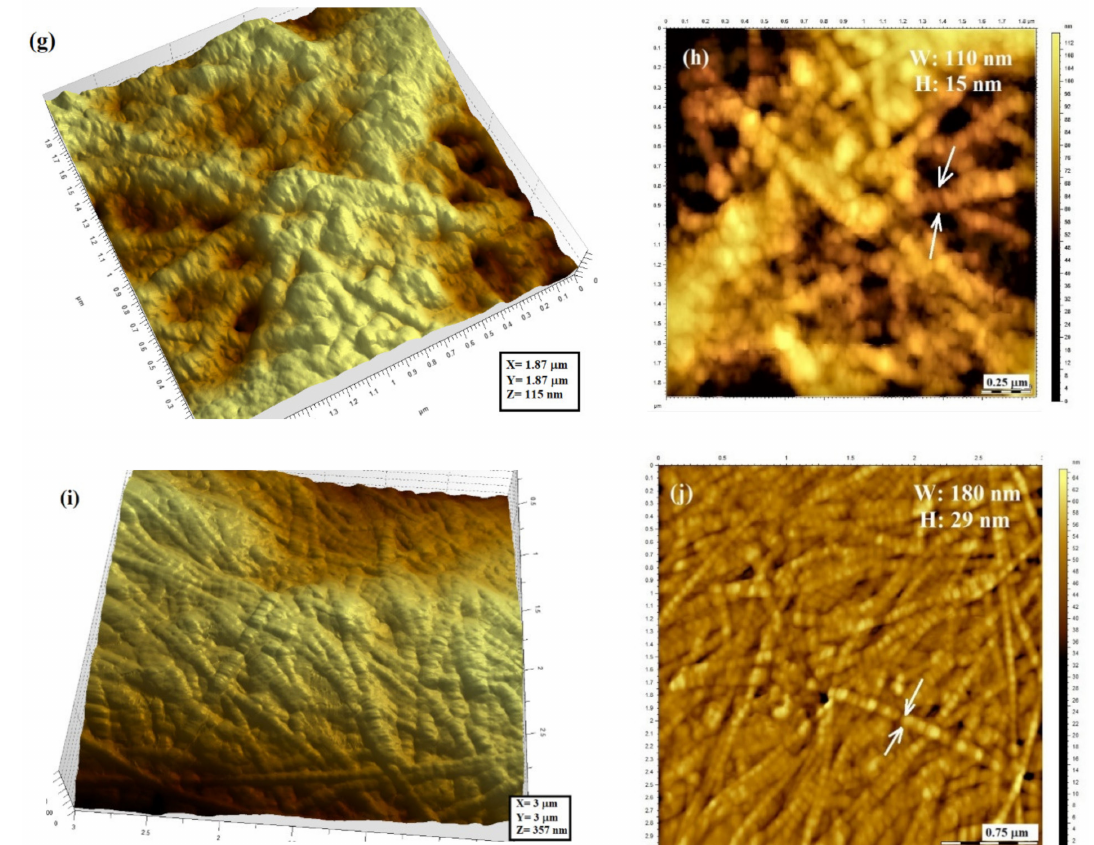
Figure 7. AFM examination of the amniotic membrane after different treatments (3D and 2D images) indicating the features of a single collagen fibril: ( a , b ) natural membrane (no treatment) (AMN); ( c , d ) membrane exposed to UV (AUV); ( e , f ) membrane exposed to gentamicin treatment 40 mg/mL (AG40); ( g , h ) membrane exposed to gentamicin treatment 80 mg/mL (AG80); ( i , j ) membrane exposed to gentamicin and UV treatment (AGUV). The profiles of a single collagen fibril exposed on the surface of the amniotic membrane after different treatments are presented in the Supplementary Materials (Figure